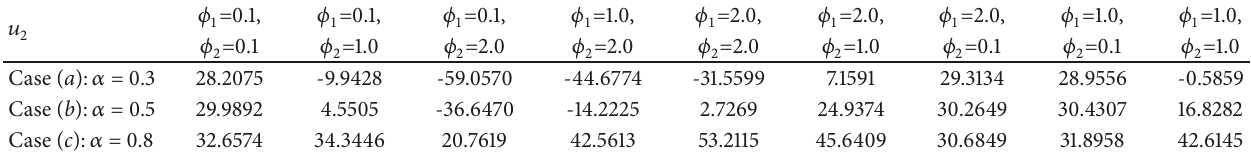
Table 7: The impact of fairness concern on player 2’s expected utility u 2 under three cases.